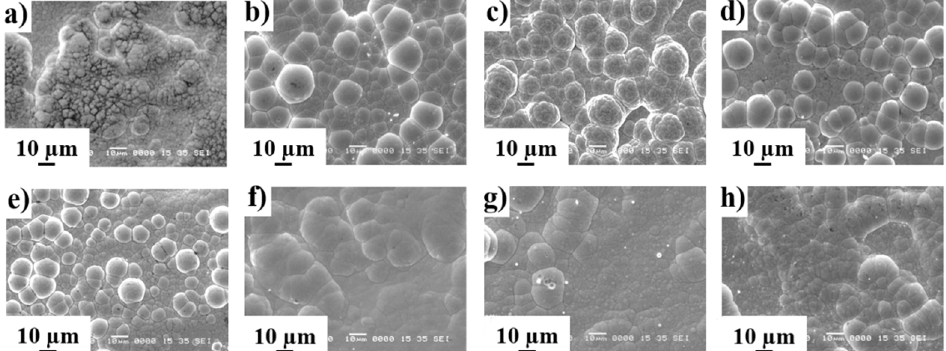
Figure 4. Top-view SEM images of ENP coatings obtained from experiment number ( a ) 1, ( b ) 2, ( c ) 3, ( d ) 4, ( e ) 5, ( f ) 6, ( g ) 7 and ( h ) 8.